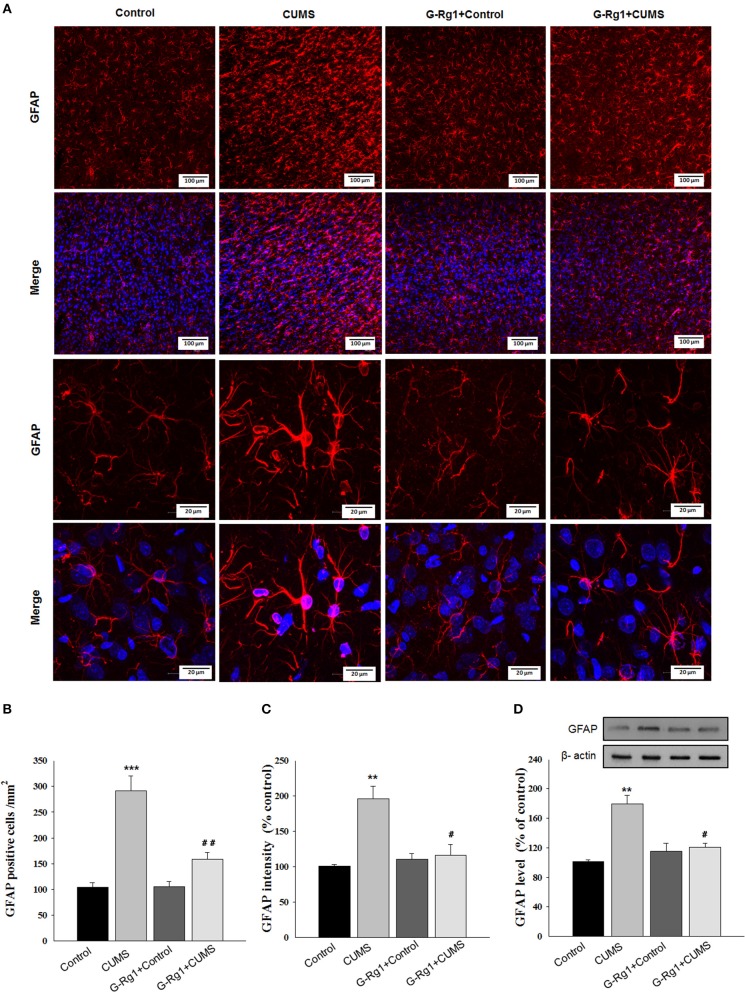
Ginsenoside-Rg1 ameliorated reactive astrogliosis within the vmPFC as induced by CUMS-exposure. (A) CUMS exposure significantly increased the number of GFAP (red) positive astroglial cells within the vmPFC, effects which were attenuated by ginsenoside-Rg1 pretreatment. Nuclei (blue) are stained with DAPI. Scale bar is 100 μm (upper) or 20 μm (bottom). (B) Bar graph illustrating the mean number of astrocytes within the vmPFC region of rats. At least 12 micrographs from 6 rats per group were analyzed. (C) Bar graph illustrating the Fluorescence intensity of GFAP within the vmPFC region of rats. (D) GFAP levels within the vmPFC region were measured at 3 days after CUMS with use of Western blot. Bar graphs show quantification of GFAP levels from Western blot. N = 6 per group. Data were presented as the means ± SEM. **P < 0.01, ***P < 0.001 CUMS vs. Control group; #P < 0.05, ##P < 0.01 G-Rg1+CUMS vs. CUMS group. (G-Rg1, Ginsenoside-Rg1).